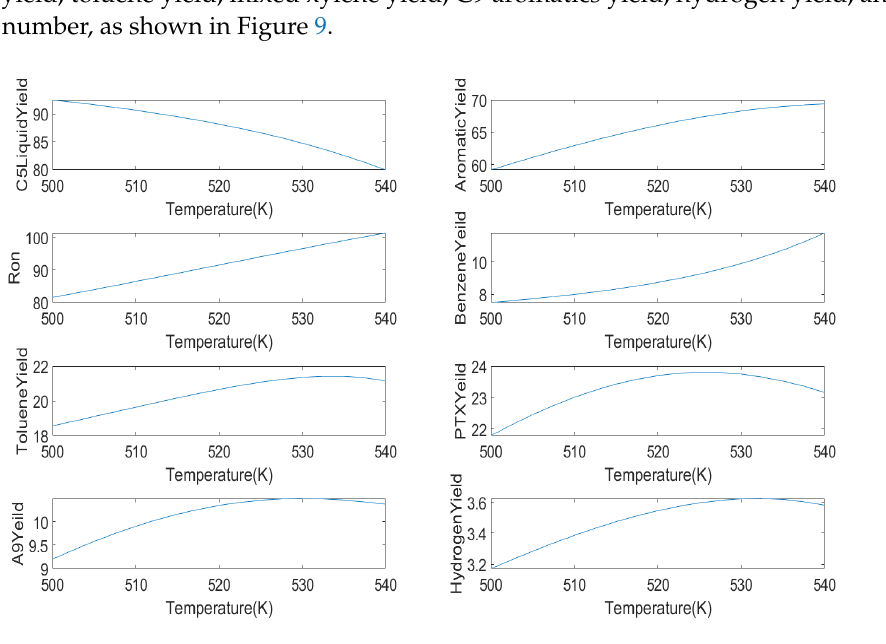
Figure 9. The influence of temperature on the yield of each